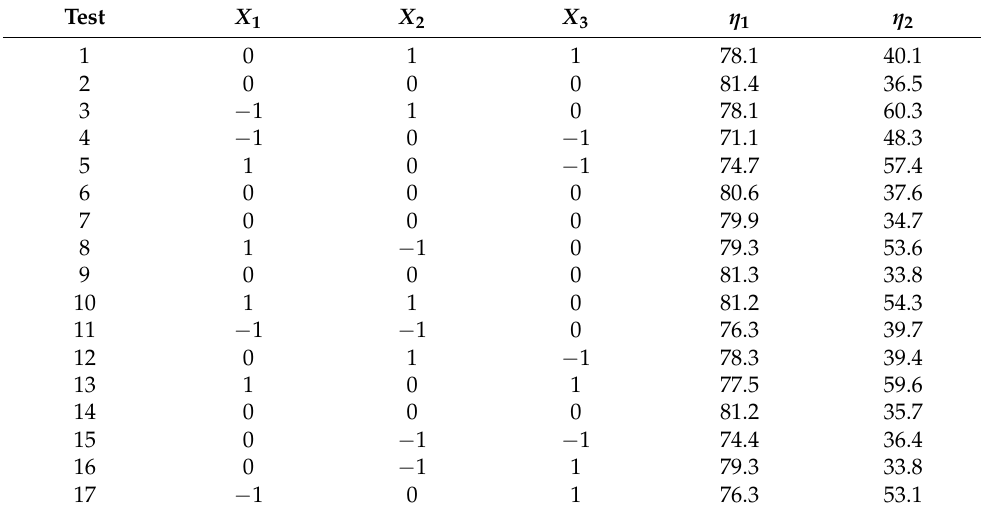
Table 4. Test plans and results.